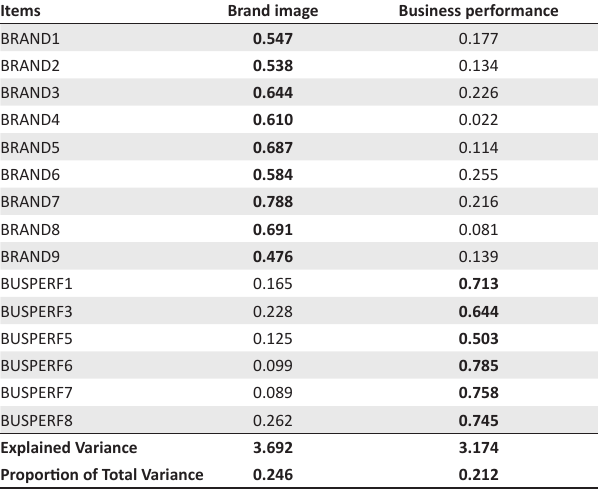
TABLE 2: Factor structure – intervening and dependent variables.